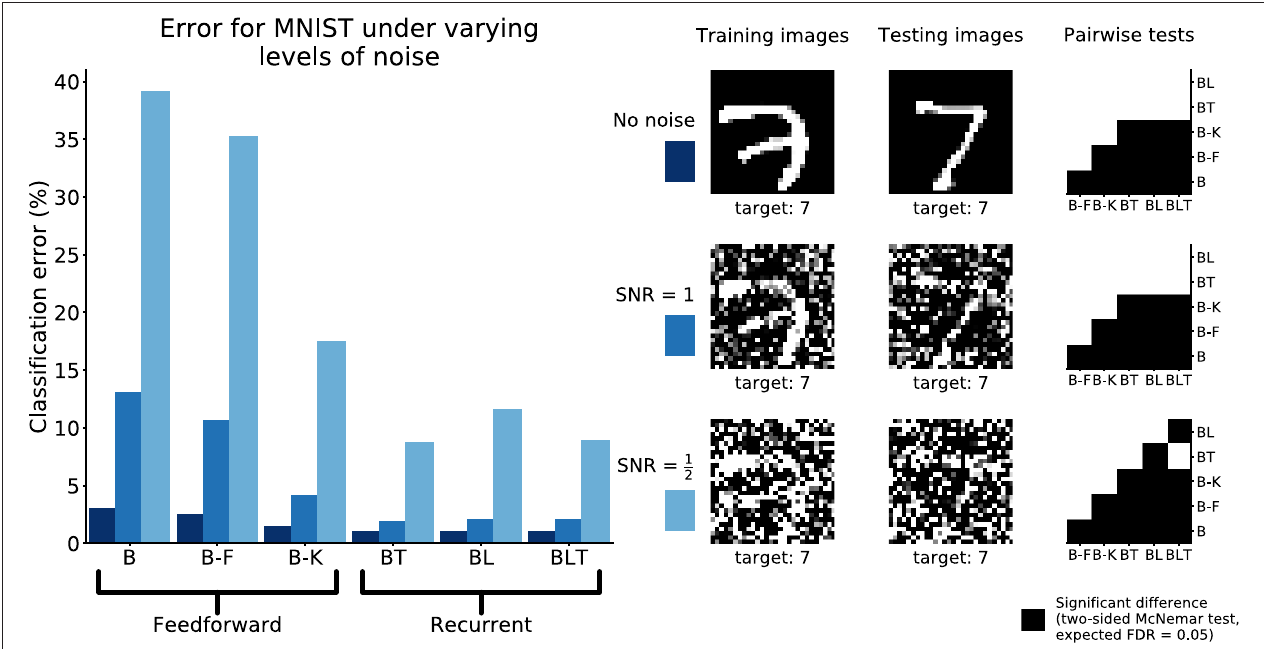
FIGURE 8 | Classification error for all models on recognition in MNIST with and without Gaussian noise. Examples of the images used to train and test the networks are also shown. Matrices to the right indicate significant results of pairwise McNemar tests. Comparisons are across models and within image sets. Black boxes indicate significant differences at p < 0.05 when controlling the expected false discovery rate at 0.05.